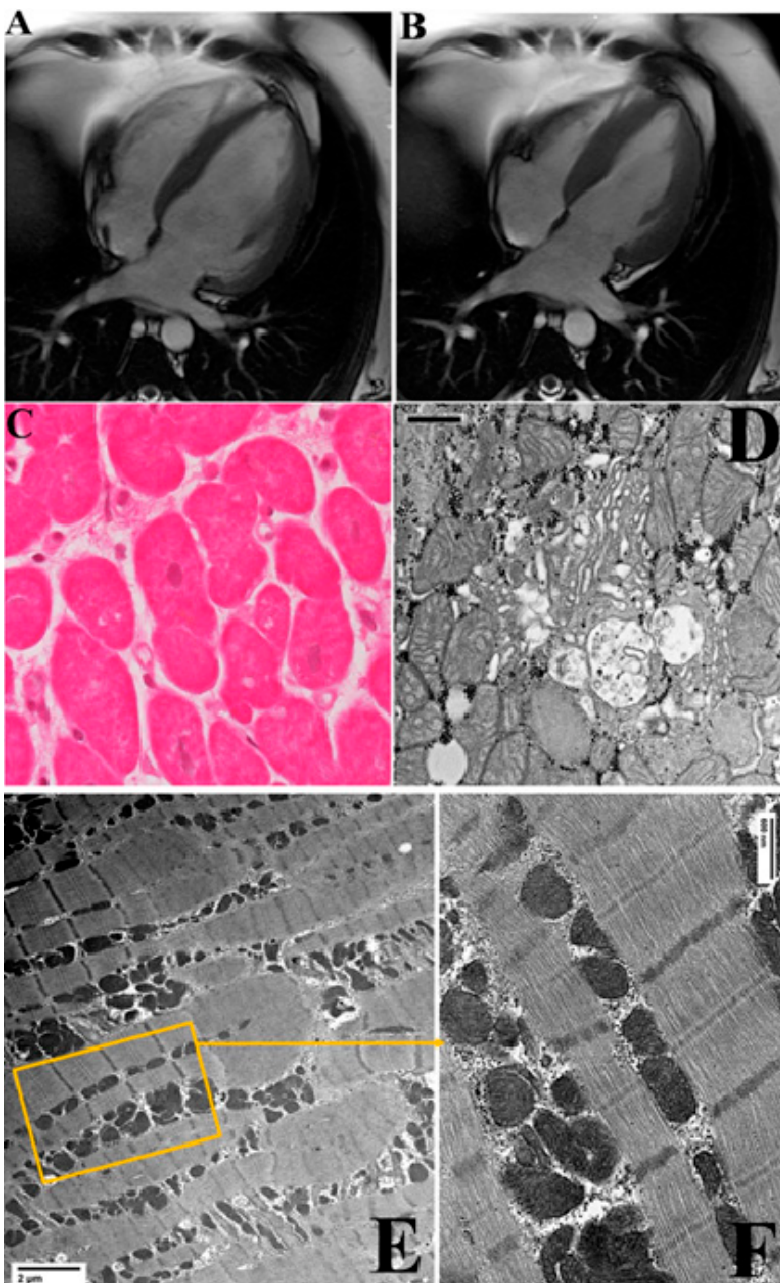
Figure 3. Clinical, histologic, and ultrastructural changes of cardiomyocytes in the 45-year-old patient with myocarditis presented in Figure 1, after cardiac recovery by immunosuppressive therapy. Panels ( A , B ): Control CMR documenting recovery of cardiac dimension and function with LVEF rising to 56%. Panel ( C ): Optical microscopy shows reduction in cardiomyocytes dimension with disappearance of vacuoles and decrease in extracellular spaces following cardiac recovery. Panel ( D ): Hypertrophic/hyperfunctioning Golgi apparatus with enlarged vesicles for water/ion extrusion (The bar represents 600 nm). Panels ( E ) Recovery of ultrastructure with normal sarcomere and mitochondrial organization. The bars represent 2 µm . Panel ( F ): detail shows energized mitochondria in columnar distribution among normal well-organized sarcomeres . The bars represent 600 nm. and 600 nm in F.